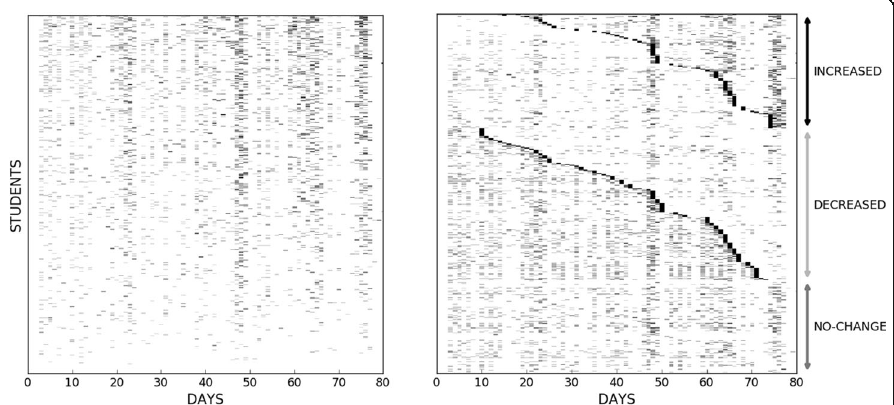
Fig. 3 The number of clicks per day shown for all the students. Left: rows sorted by the number of total clicks, Right: rows are first grouped as three different behavioral groups, and then ordered by the chronological location of the changepoint per student within each group. The black markers indicate detected changepoints. Figure based on data and analyses in Park et al.